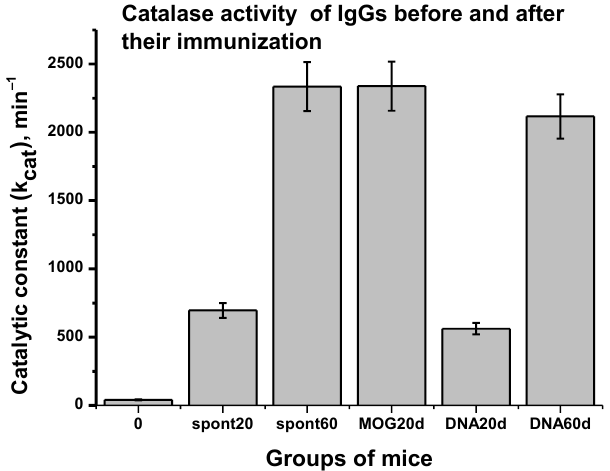
Figure 4. Relative average catalase activity of IgGs from different mouse groups: 0 (3-month-old mice), spon20 and spon60 (spontaneous development of EAE during 20 and 60 days, respectively), MOG20d (20 days after immunization of mice with MOG), and DNA20d and DNA60d (20 and 60 days after immunization of mice with the DNA–histone complex, respectively).